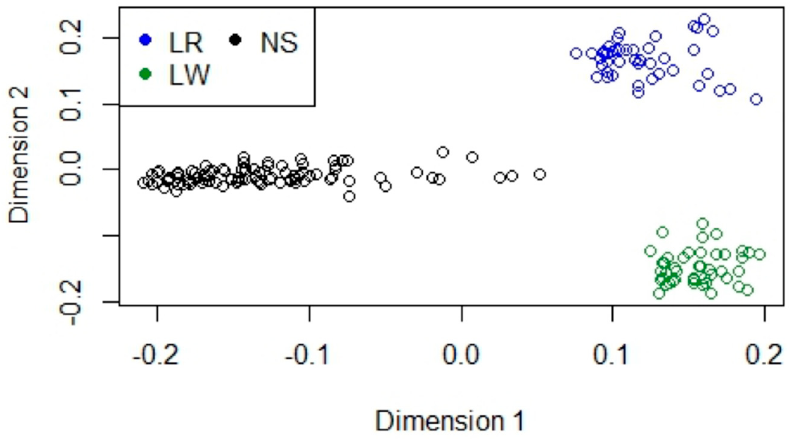
Figure 1. Multidimensional Scaling. Analysis of Nero Siciliano (NS), Landrace (LR), Large White (LW), Duroc (DU), and Wild Boar (WB).